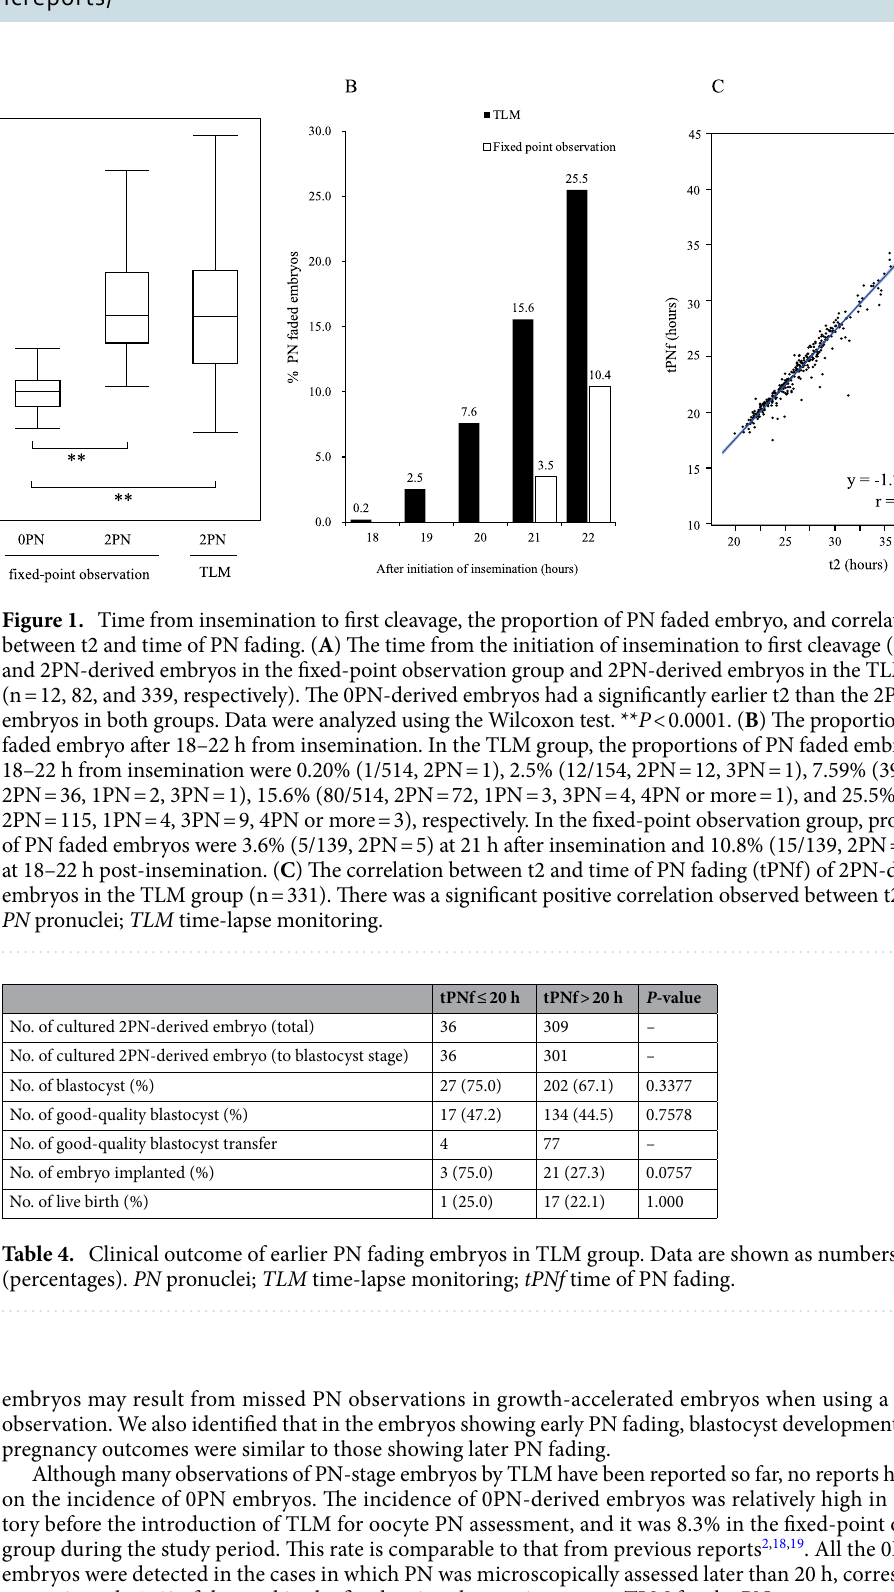
on the incidence of 0PN embryos. The incidence of 0PN-derived embryos was relatively high in our labora- tory before the introduction of TLM for oocyte PN assessment, and it was 8.3% in the fixed-point observation group during the study period. This rate is comparable to that from previous reports 2,18,19 . All the 0PN-derived embryos were detected in the cases in which PN was microscopically assessed later than 20 h, corresponding to approximately 15% of the total in the fixed-point observation group. TLM for the PN assessment revealed that PN in 7.59% of embryos (39/514) had already disappeared at 20 h after insemination (Fig. 1B). The mean t2 of the 0PN-derived embryos reached 4.8 h sooner than that of the 2PN-derived embryos. Moreover, two healthy babies were born following the 0PN-derived blastocyst transfer during the study period. These results suggest that the early fading of PN in growth-accelerated embryos results in the appearance of PN being overlooked and misjudged as a 0PN-derived embryo. Recently, Fu et al. reported that rapidly developed 0PN-derived embryos have better developmental ability 8 , and these findings are consistent with those of our present study. The incidence of 0PN embryos in cIVF may be affected by human errors, and this can be reduced by making minor changes